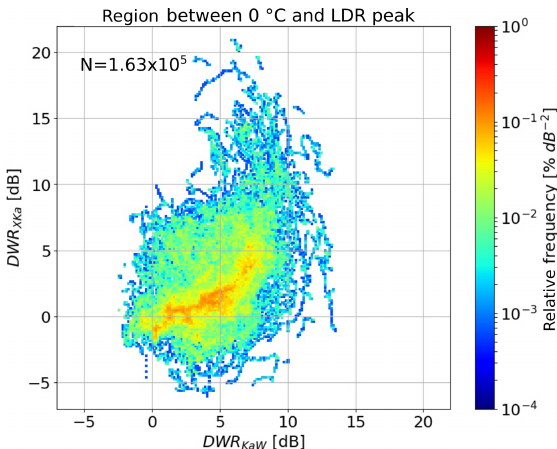
Figure 11. Two-dimensional histogram of the triple-frequency sig- natures for the region between 0 ◦ C and the LDR maximum in the melting layer normalized by the total number of points N . The color shows the relative frequency, and the binning matches what was used for Fig. 10. Note the log scale on the color